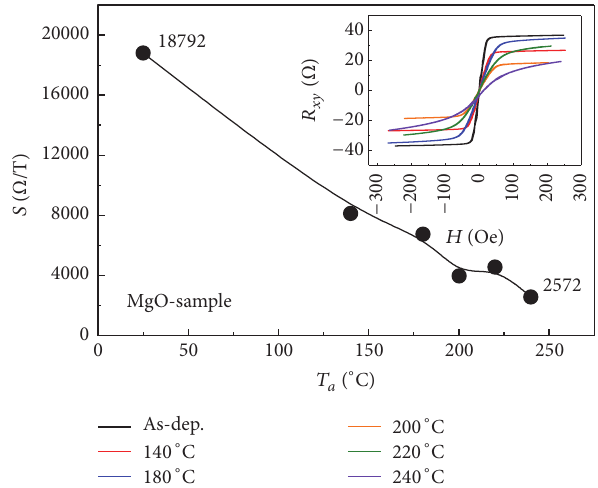
Figure1:AnnealingtemperaturedependenceoftheanomalousHall sensitivity for the sample Ta(0.8)/Co 20 Fe 80 (0.8)/MgO(0.8)/Ta(1.0) (in nm). Inset: anomalous Hall loops of the sample in the as- deposited and different annealed states.